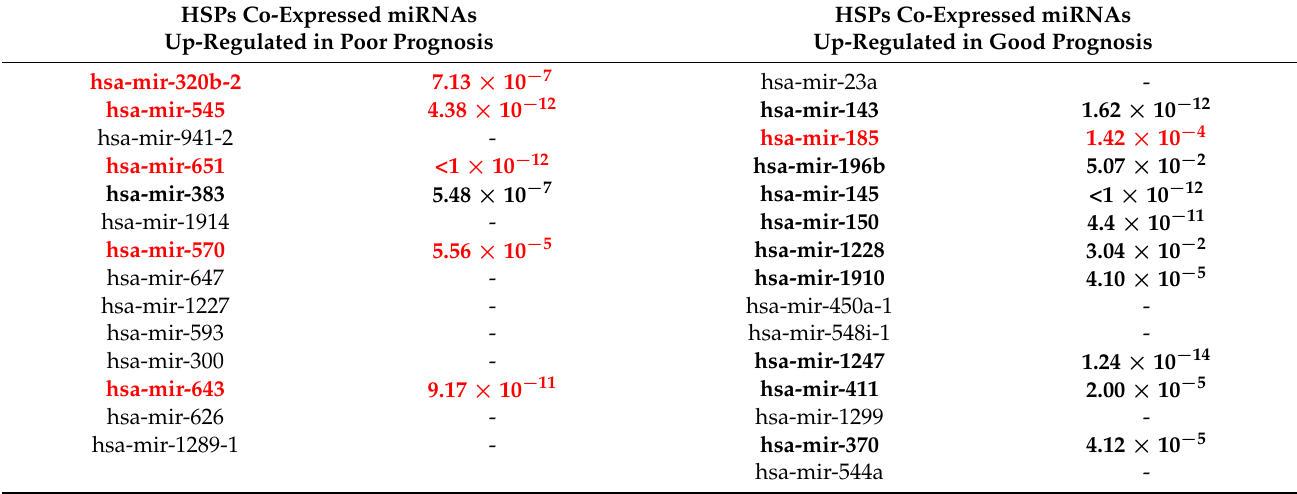
Table 5. List of the hubs miRNAs involved in the HSPs-miRNAs-mRNAs network. The red bolded miRNAs were significantly up-regulated in breast cancer than normal tissues; the black bolded miRNAs were significantly down-regulated in breast cancer than normal tissues. A p -value < 0.01 was regarded as